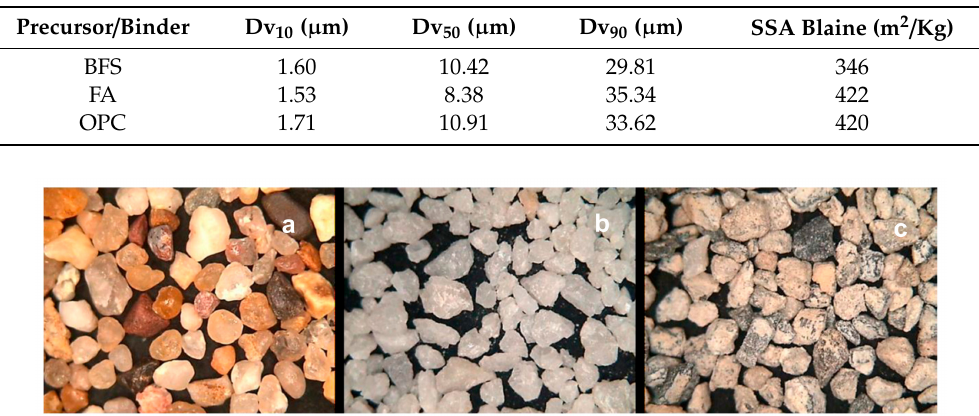
Table 2. Particle size distribution of blast furnace slag (BFS), fly ash (FA), and cement (OPC).